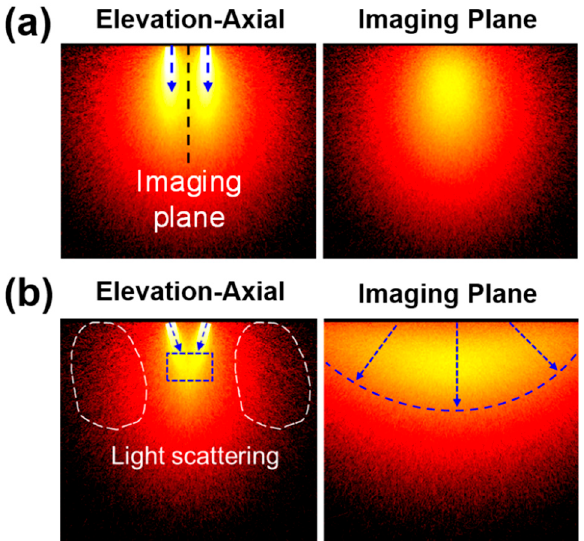
Figure A3. Results of the Monte Carlo simulation for light propagation in optical scattering media; light is delivered ( a ) in parallel and ( b ) at an oblique angle.